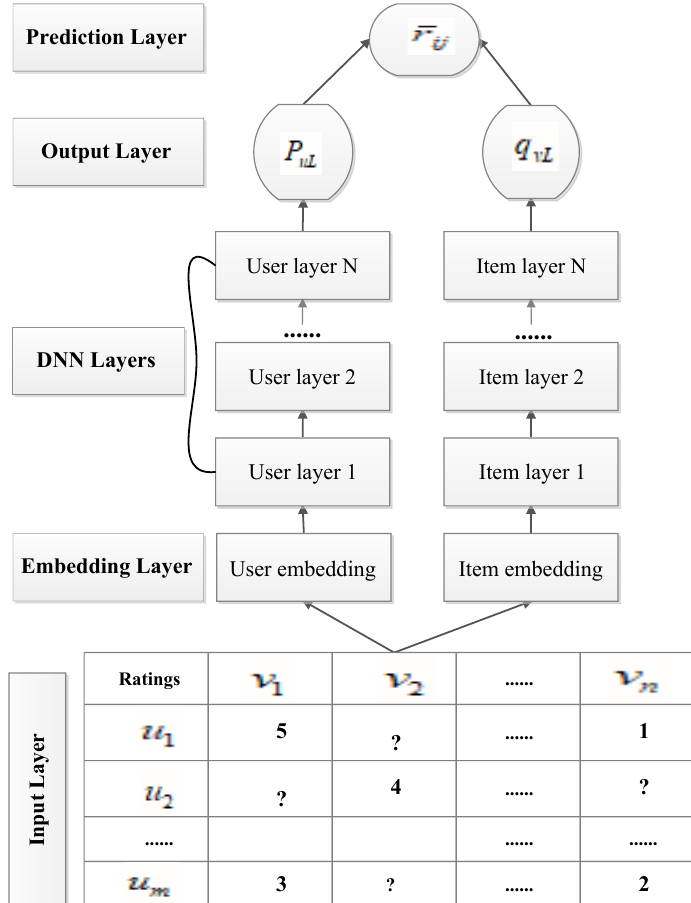
Figure 1. General scheme of the proposed model. The architecture consists of an embedding layer with a dense vector obtained from the input matrix, followed by deep neural network layers. In the output layer, the method generates the latent factors that are used for rating prediction in the prediction